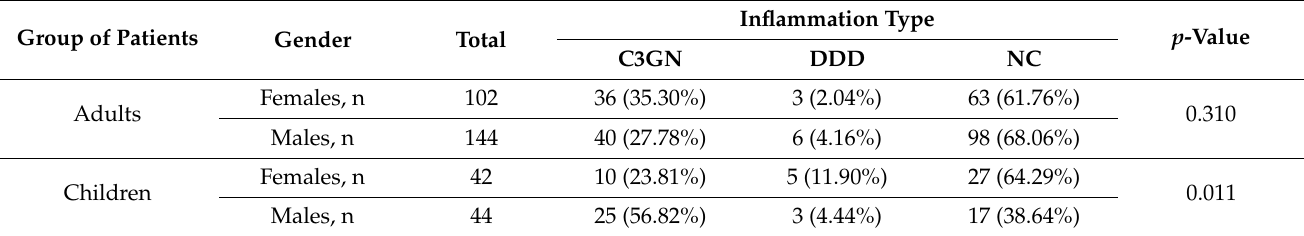
Table 2. Clinical symptoms in adults and